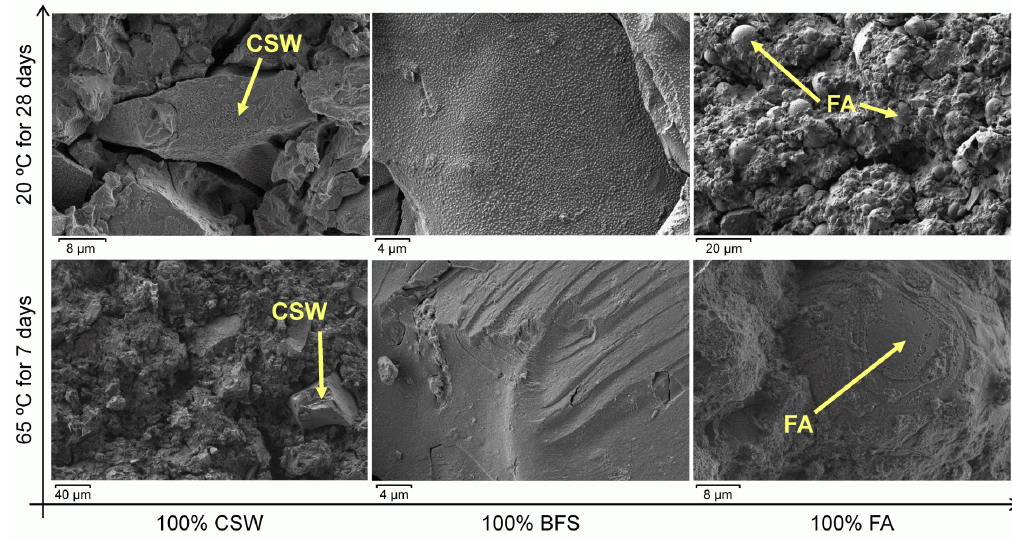
Figure 12. The field emission scanning electron images of the 100 wt % CSW, BFS, and FA alkali-activated pastes cured at 20 °C for 28 days and at 65 °C for 7 days. CSW: ceramic sanitaryware particles; FA: fly ash particles, N–(C)–A–S–H/C–S–H/C–A–S–H: alkali-activated gels.